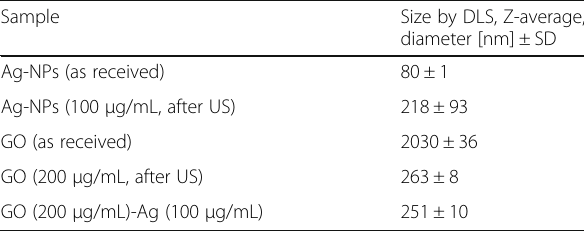
Table 2 Test results of average particle/agglomerate size in suspensions